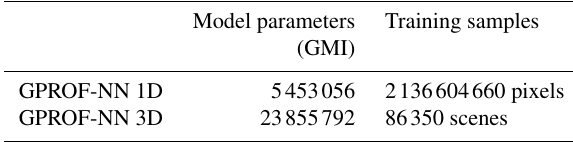
Table B1. Sizes of neural network models and the training